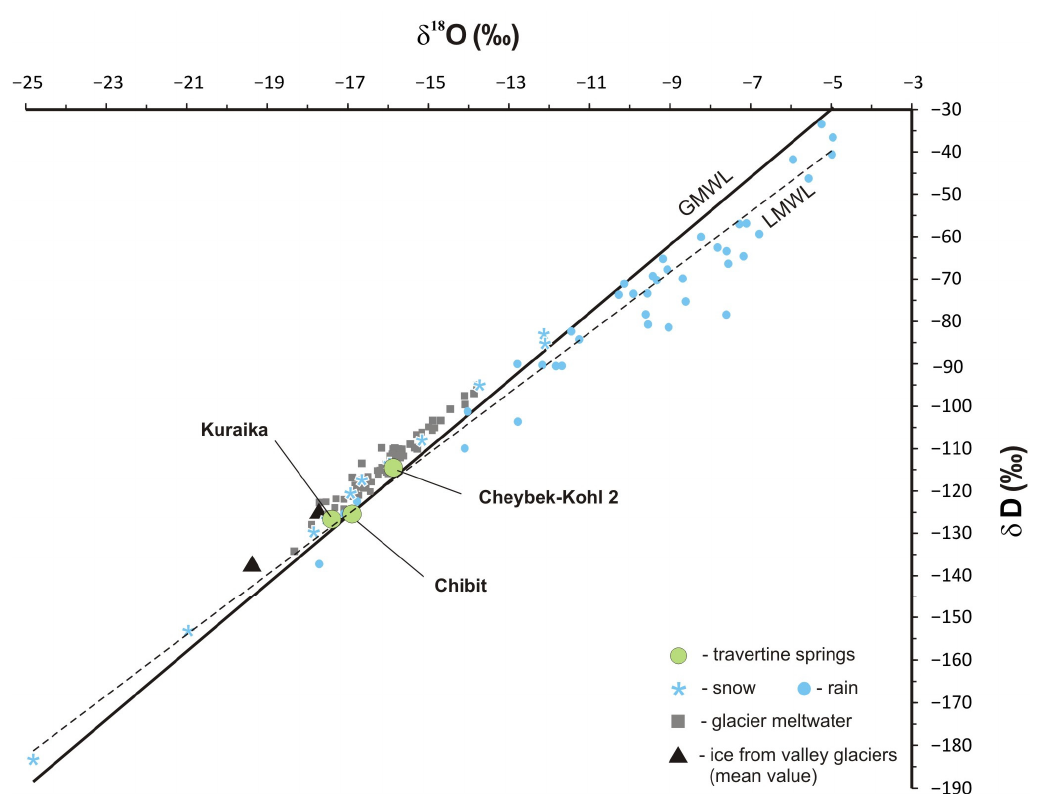
Figure 11. The isotope composition of the travertine water compared with ice and meltwater of the south-eastern Gorny Altai as well as meteoric precipitation. Sources: Glacier meltwater and ice from valley glaciers in Tavan-Bogd and Mongun-Taiga massifs [93,94]. Local meteoric water line (LMWL;